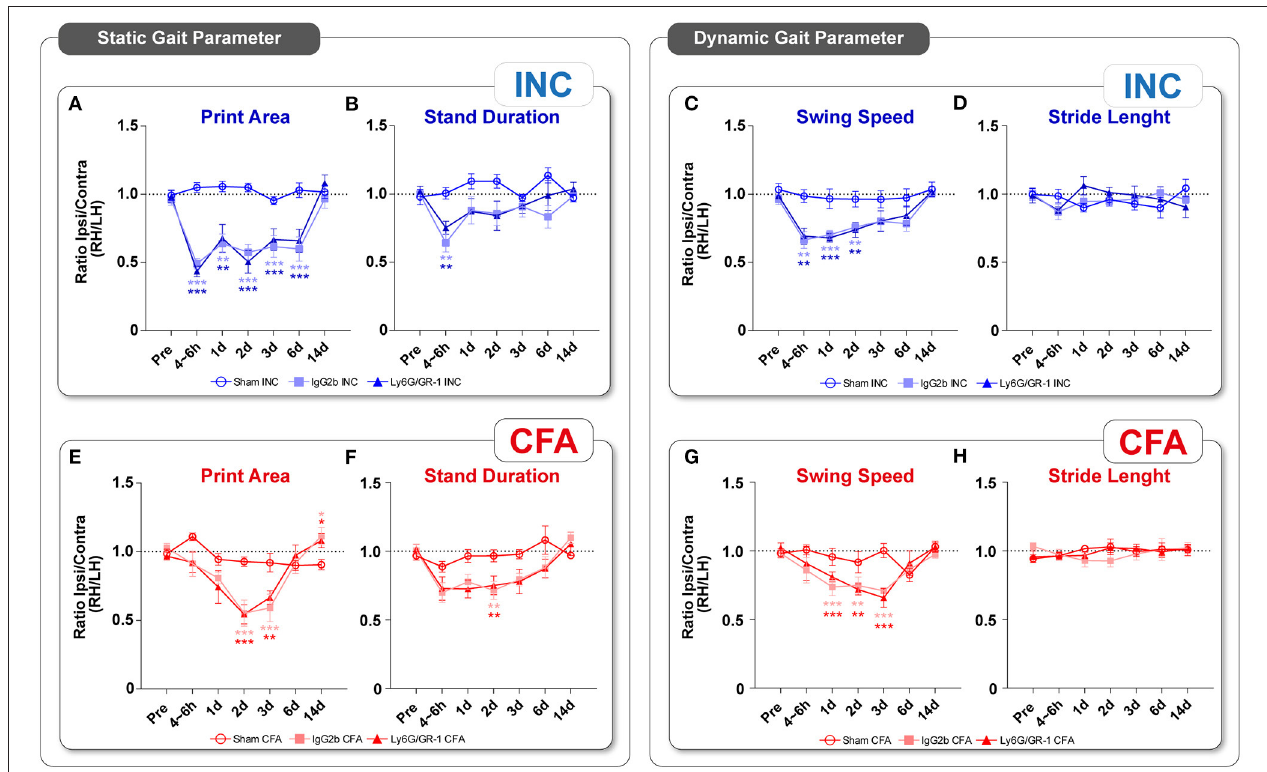
FIGURE 4 | Antalgic gait after plantar incision or CFA. Upon INC, print area (A) was reduced until 6 days, whereas stand duration (B) and dynamic swing speed (C) were reduced in the acute phase after incision. Print area (E) was reduced in CFA at days 2, 3, and 14 , whereas stand duration (F) and swing speed (G) were significantly altered at later time points. No changes were observed for the gait parameter stride length in both models (D,H) . Ly6G/GR-1-treated mice showed no differences to vehicle-treated groups, independent of pain model. No gait changes were observed in the Sham-mice. All experimental groups contain eight mice (cohort 2). The results are expressed as mean ± SEM. Values of p : * p < 0.05, ** p < 0.01, *** p < 0.001 vs. Pre, † p < 0.05, †† p < 0.01, ††† p < 0.001 vs. Vehicle (IgG) by Kruskal–Wallis and Dunnett’s multiple comparison